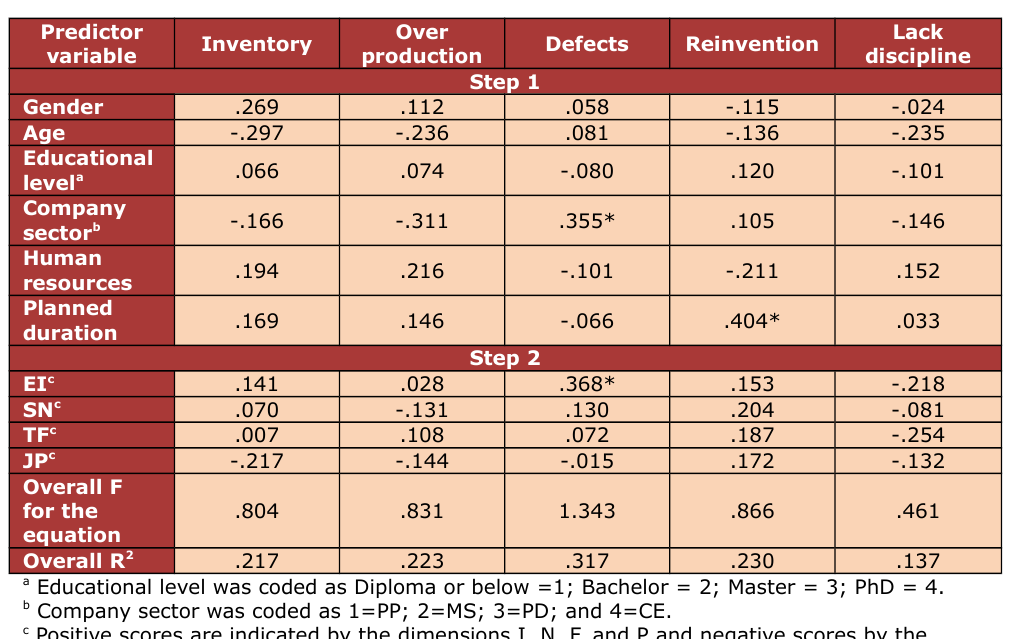
Table 11. Effect of EI, SN, TF and JP on VSM performance